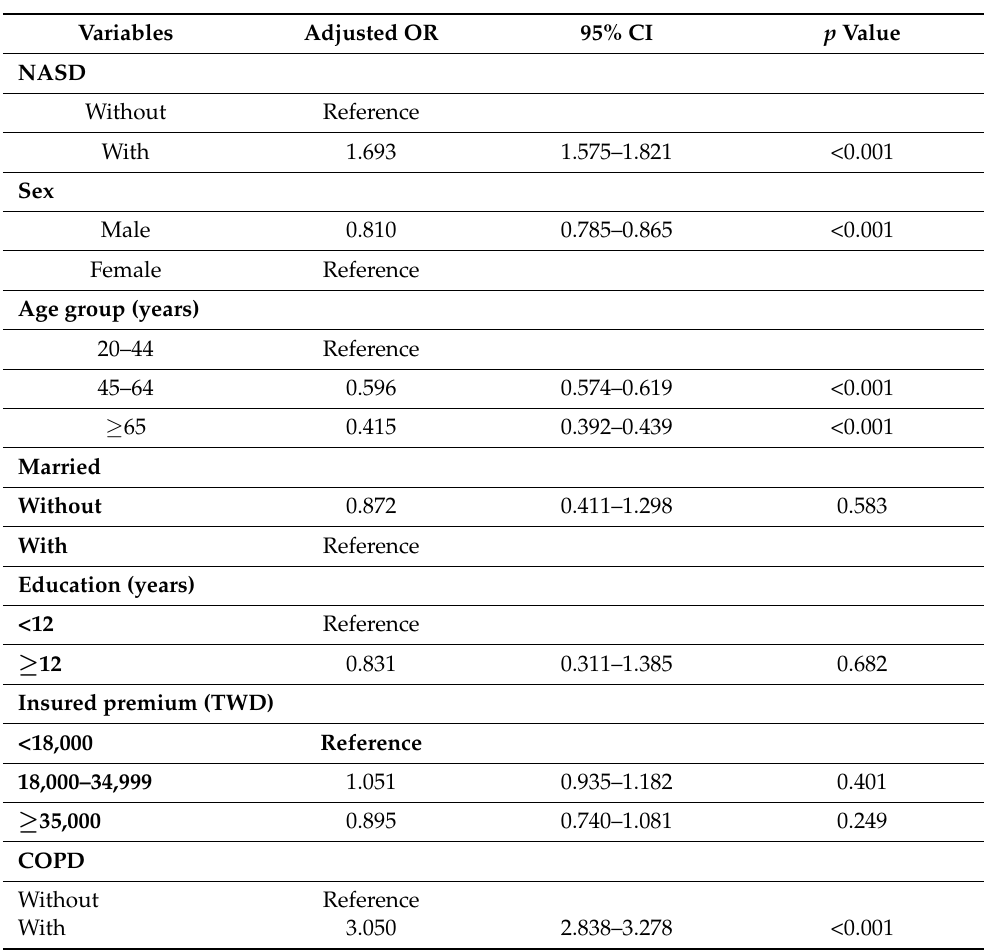
Table 2. Logistic regression of obesity